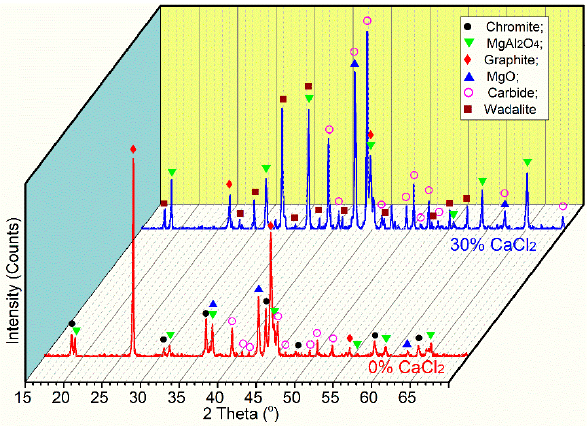
Figure 4. XRD patterns of the reduced products from the tests with no additive and 30 wt % CaCl 2 addition.